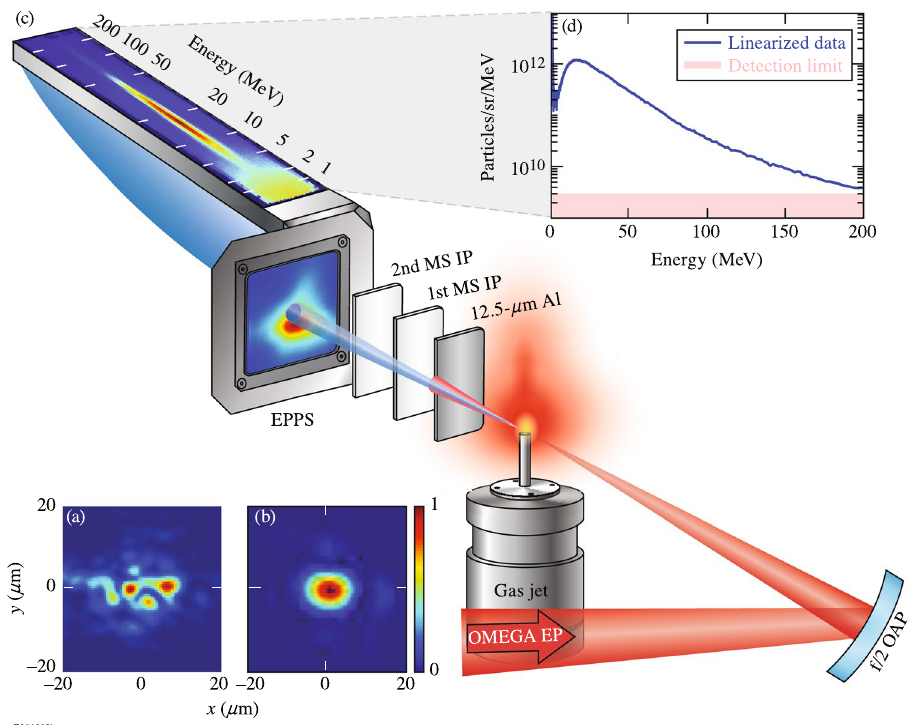
Figure 2. ( a , b ) Examples of target spot at focal plane for the standard OMEGA EP f/2 focus and the f/6 apodized focus, respectively, measured on-shot using a hybrid Shack-Hartmann-phase-retrieval-based wavefront sensing method 32,33 . The peak fluence per energy for ( a ) and ( b ) is 7.9 and 11.8 × 10 5 cm −2 , respectively. Note that the apodized focal spot in ( b ) produces a single, high-intensity laser spot ideal for driving high-quality SMLWFA in contrast with the multiple hot spots that exist with the f/2 focus. ( c ) Relative layout of the laser, target, and diagnostics. ( d ) Electron spectrum from an a 0 = 5.1 laser shot propagating through a plasma density of 5.4 × 10 18 cm −3 generated by a 6-mm-diameter nozzle. The shaded region marks the detection limit of the EPPS. OAP: off-axis parabola.